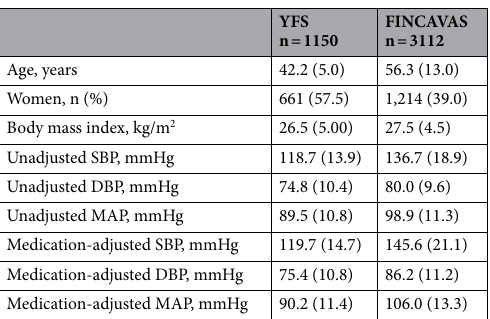
Table 1. Baseline characteristics of the YFS and FINCAVAS cohorts. Values are means (SD). YFS Young Finns Study, FINCAVAS Finnish Cardiovascular Study, SBP systolic blood pressure, DBP diastolic blood pressure, MAP mean arterial pressure.